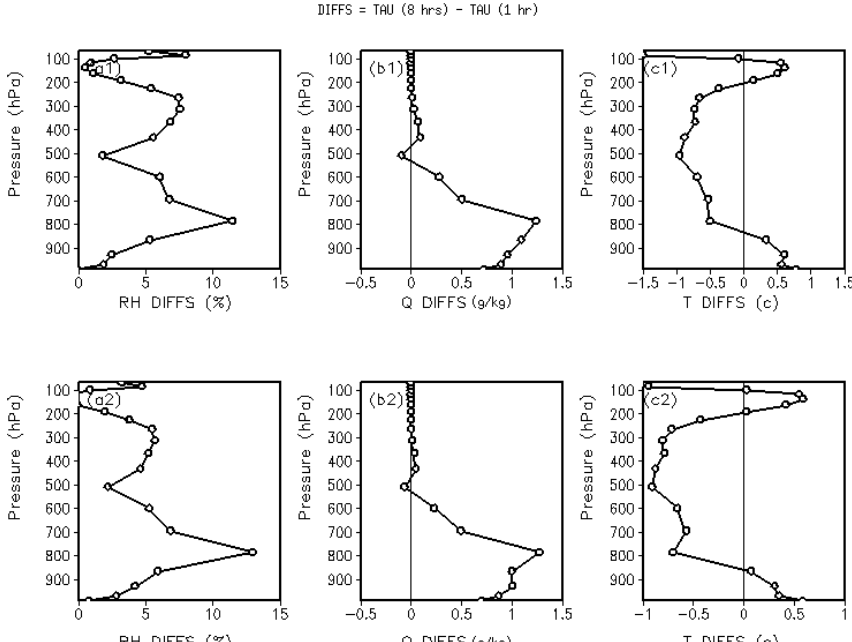
Fig. 19. Vertical profile of the difference of the area averaged, time mean, quantities between TAU (8h) and TAU (1h), at the raining points. grid points where the total precipitation is more than 1mm/day are considered as the raining points. Top panel for the deep tropics (0 ◦ E to 360 ◦ E and 12.5 ◦ S to 12.5 ◦ N) and bottom panel for the whole tropics (0 ◦ E to 360 ◦ E and 30 ◦ S to 30 ◦ N). (a1) and (a2) RH difference (%), (b1) and (b2) specific humidity difference (gram/kg), (c1) and (c2) atmospheric temperature difference ( ◦ C). Time mean is calculated by averaging over all the months of 10